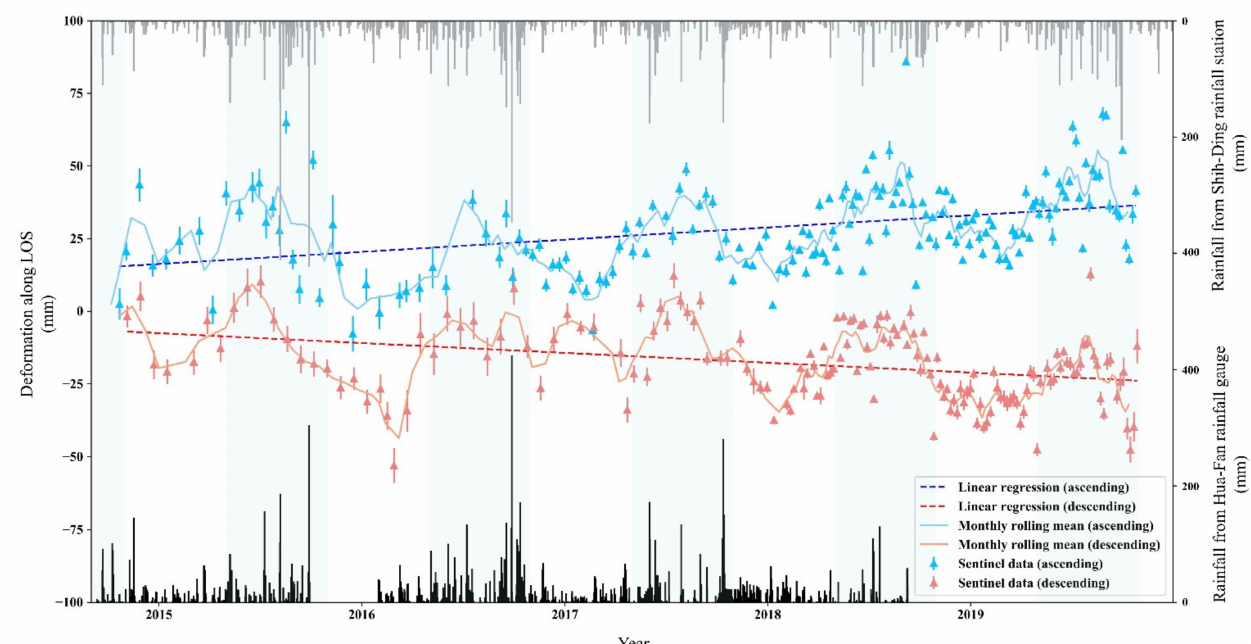
Figure 7. The comparison between time series derived from ascending and descending orbital geometries, seasonal surface fluctuation and gravity-induced deformation are clearly shown. The seasonal surface fluctuation is in-phase with the precipitation data. According to the two precipitation records derived from the Huafan University campus and the Shih- Ding rainfall stations with a distance of approximately 4 km, the trend of daily precipitation from the two rainfall stations is similar, but the amounts of daily precipitation are different. Thus, setting the precipitation threshold value of an early warning for possible landslide hazards should take care when using the data from the nearby Shih-Ding rainfall